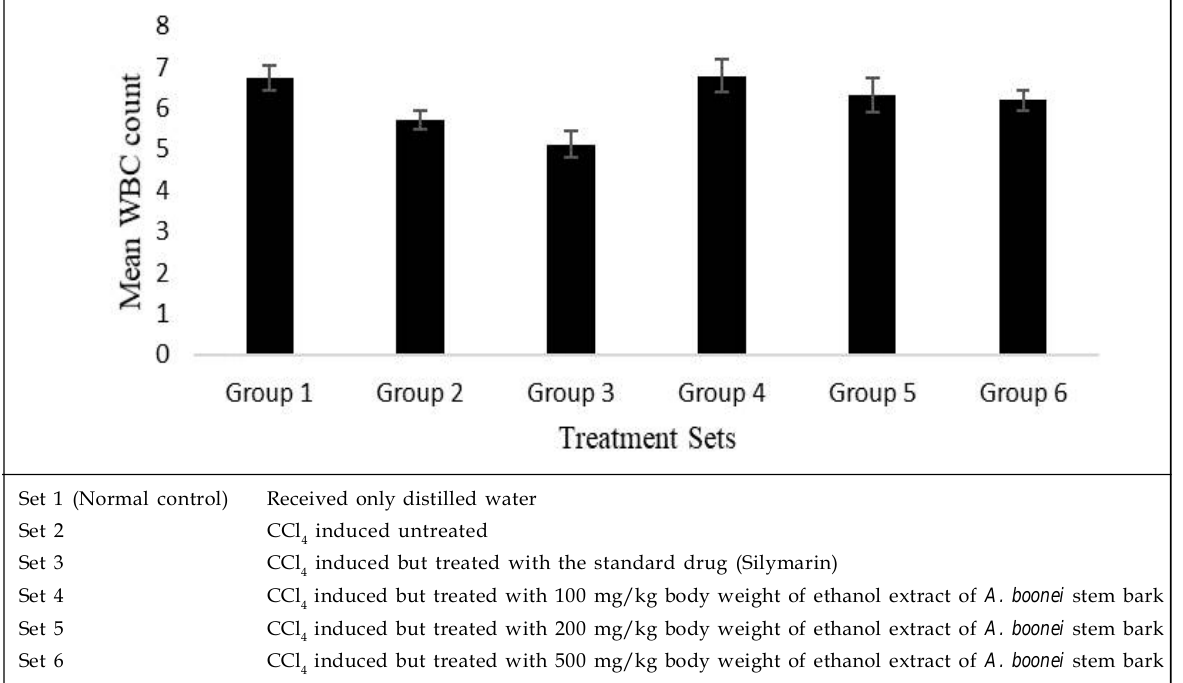
Set 1 (Normal control)